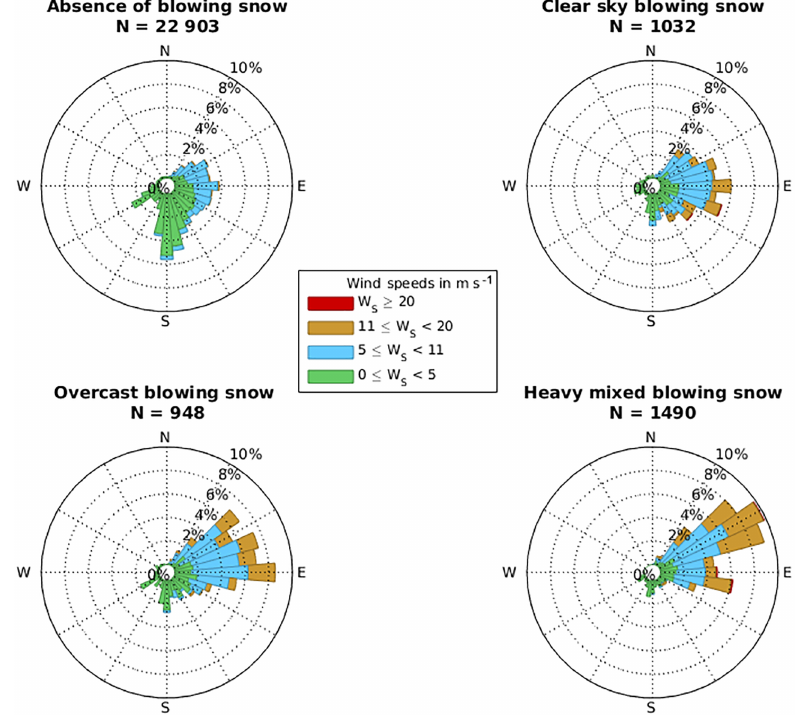
Figure 9. Wind roses presenting the wind direction for the absence of blowing snow ( N = 20948), blowing snow with ( N = 3834) or without precipitation ( N = 1237), and heavy mixed blowing snow ( N = 10351) at Neumayer III station